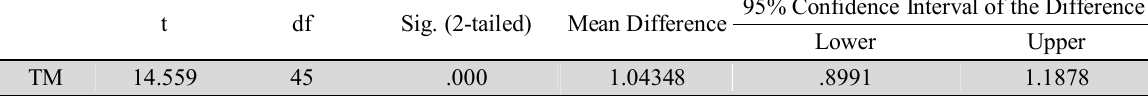
The summary of testing the effect of improvement on quality of different tasks (IQDT) (Test value = 3)